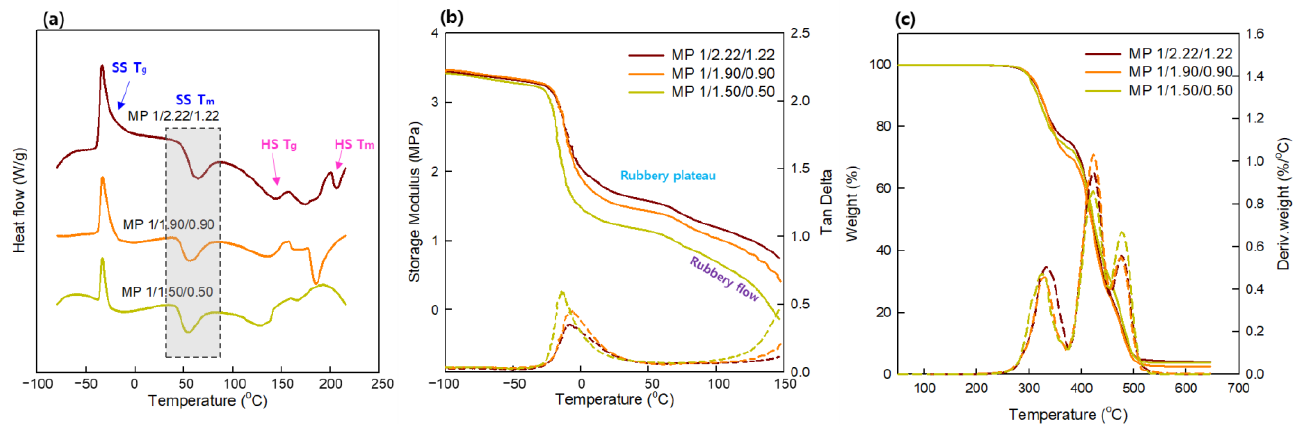
Figure 6. ( a ) Differential scanning calorimetry results for the first heating cycle. ( b ) Plots of the storage modulus versus temperature and tan δ versus temperature from dynamic mechanical analysis.